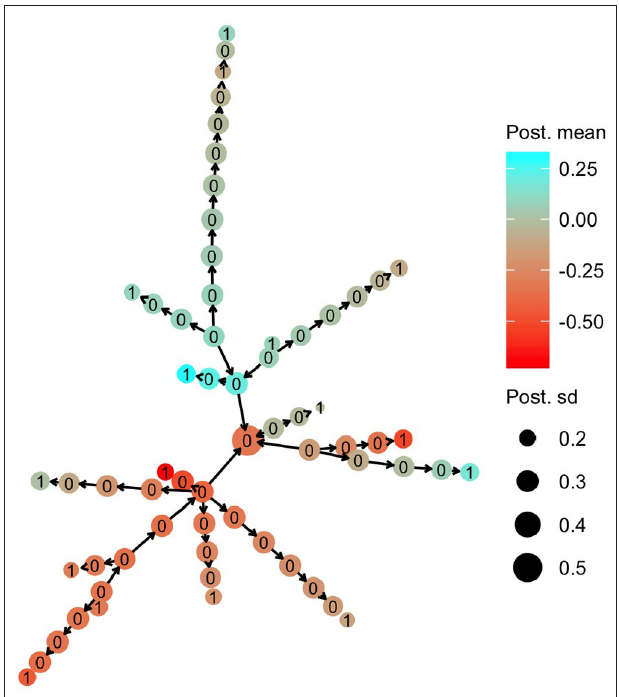
FIGURE 5 | Posterior mean and standard deviation for mitochondrial haplotype effects on milk yield in cattle. Posterior means are denoted with node color, while posterior deviations are denoted by the node size. The numbers on each haplotype node indicate if the haplotype had a direct link to the observed phenotype (1) or not